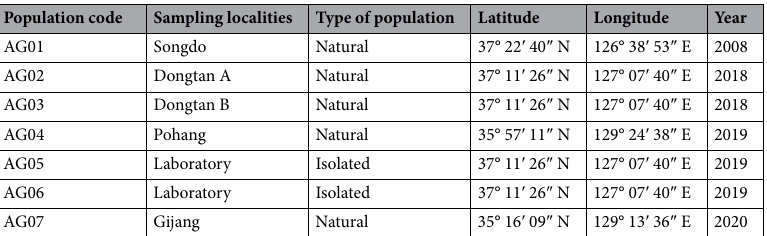
Table 1. Information of sampling sites, population code, type of population (e.g., natural and isolated), latitude/longitude, and sampling year for Asynapta groverae populations in South Korea.